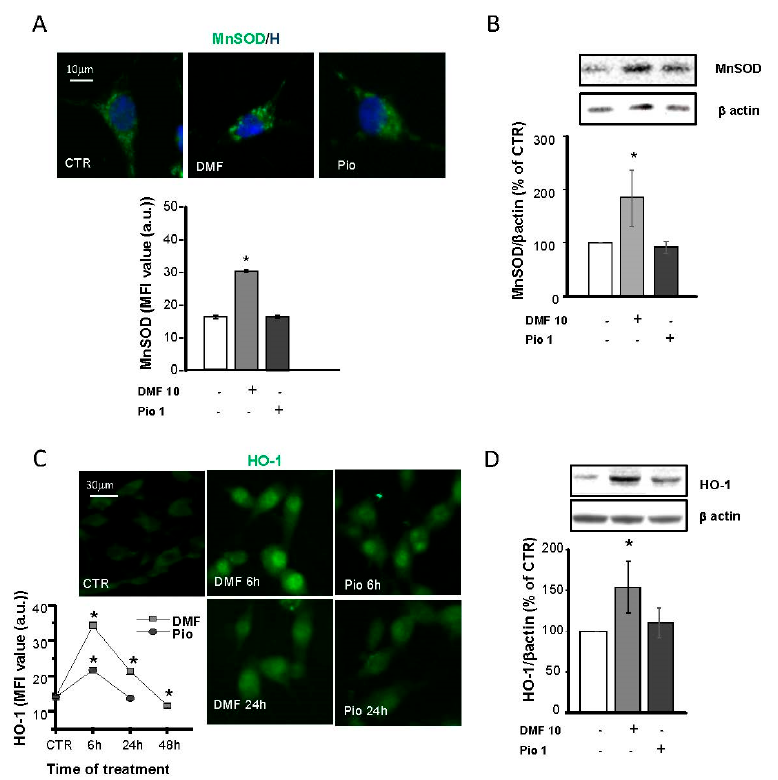
Figure 4. DMF and pio differently regulate the antioxidant enzymes heme oxygenase 1 (HO-1) and MnSOD. OP cultures treated for 24 h (unless indicated) with 10-µM DMF or 1-µM pio were immunostained for MnSOD ( A ). The micrographs show MnSOD (green) and Hoechst 33258 (blue, H). The bar graph shows MFI analysis of the CTR and treated cells ( n = 250–300 cells; * p < 0.05 vs. CTR). WB analysis of MnSOD expression is shown ( B) . Representative bands of MnSOD and β -actin